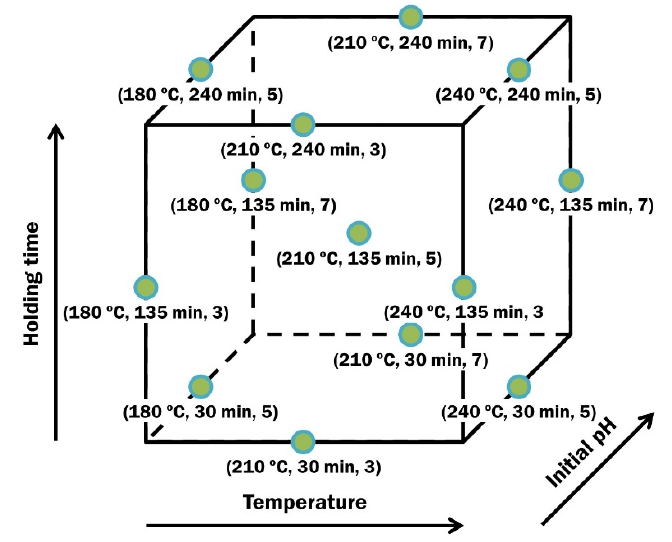
Figure 1. Graphical illustration of the chosen design space.